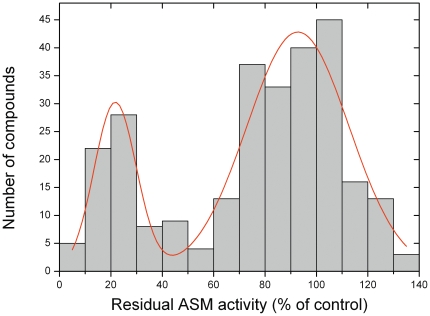
Analyzed compounds show a bimodal distribution with respect to functional inhibition of ASM.The histogram includes results of 276 experimentally investigated compounds (see Table S1). The line represents a Gaussian fit to the two peaks.